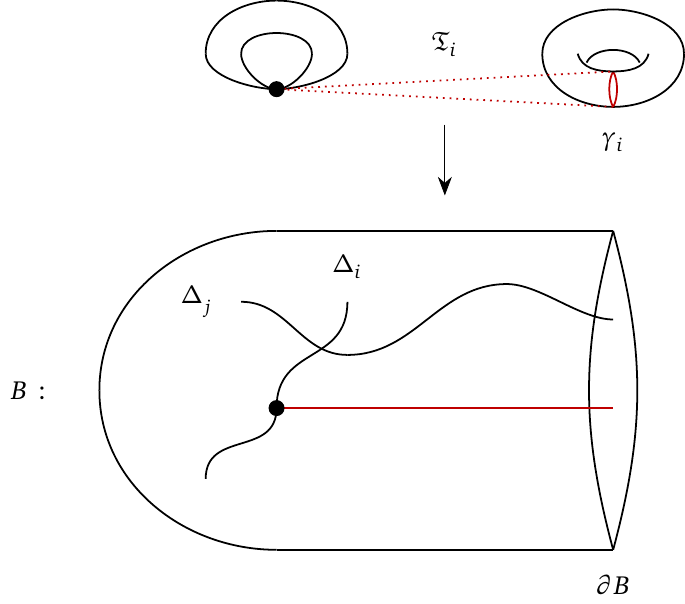
Figure 1: Elliptic Calabi-Yau an n -fold X → B with discriminant ∆ containing a com- pact and non-compact components denoted ∆ ∈ h thimble T ( 2 ) (dotted red) is fibered by a vanishing cycle of i ∈ H ( ∂ X ) . It projects to a semi-infinite path in the base (red) starting boundary in γ i 1 at the discriminant and ending at the boundary of the